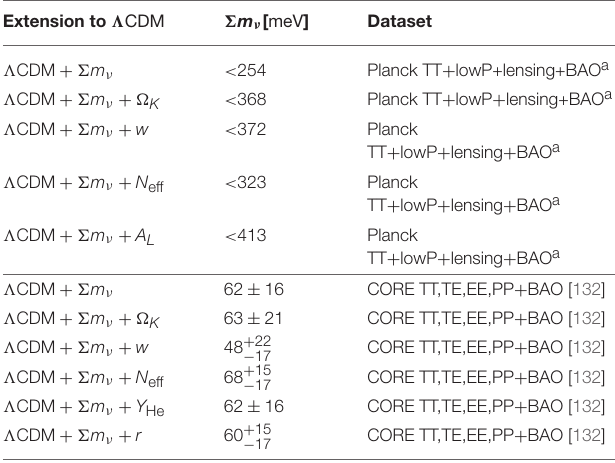
TABLE 3 | Constraints on 6 m ν from different extensions to the 3 CDM model for the indicated